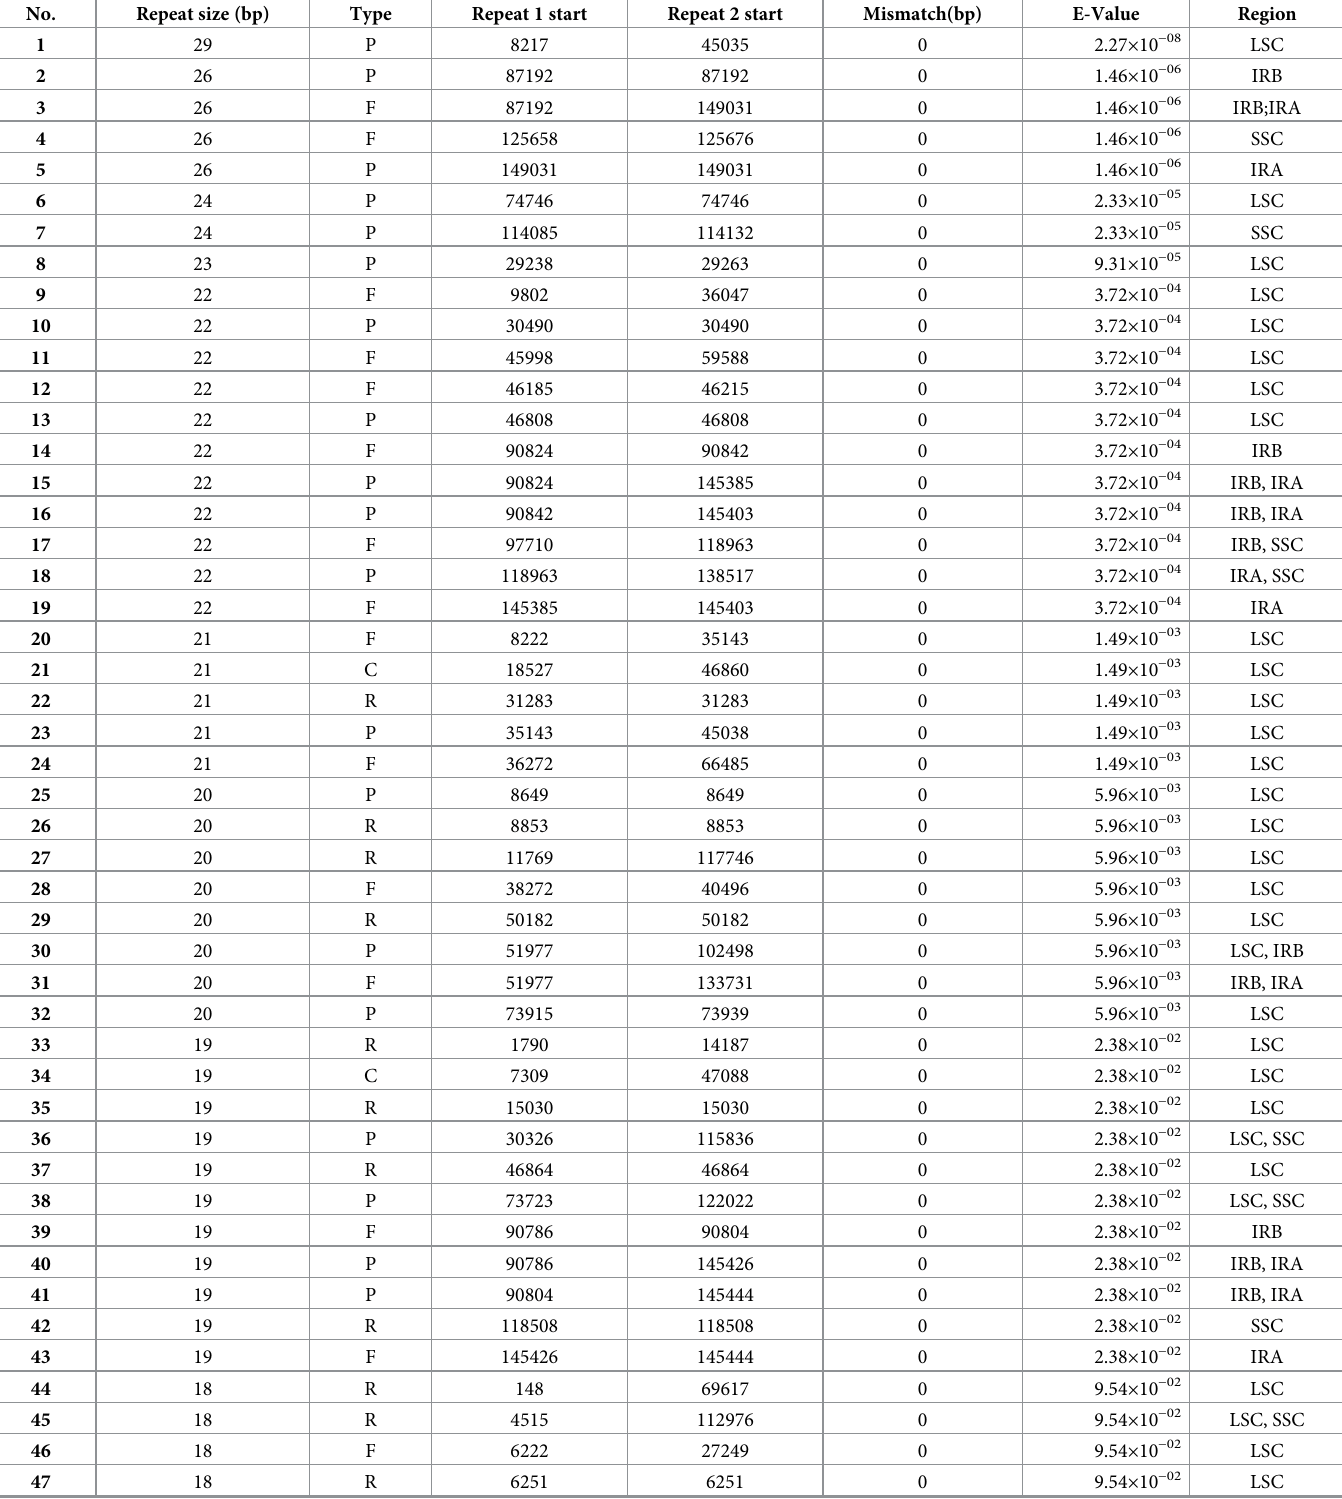
Table 4. Long repeat sequences identified in the chloroplast genome of I . rubescens .